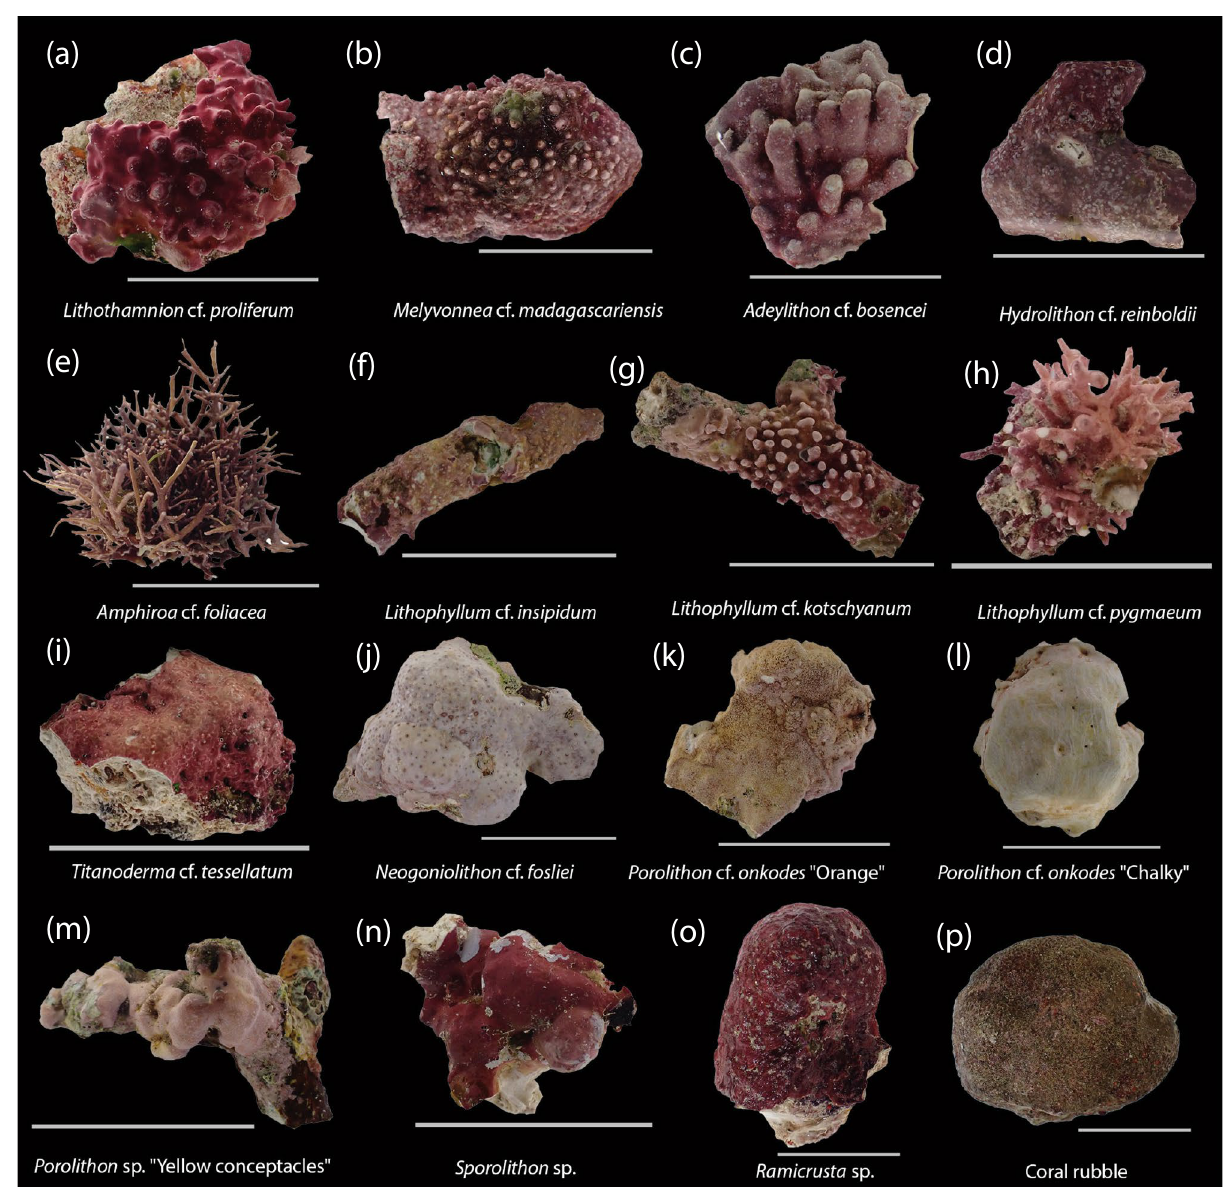
Figure 1. ( a ‒ n ) Sample fragments of coralline red algae (including crustose coralline algae and articulated, geniculate coralline algae), ( o ) Ramicrusta sp. (Peyssonneliaceae) and ( p ) coral rubble collected from the Great Barrier Reef and tested in the study. Scale bar = 5